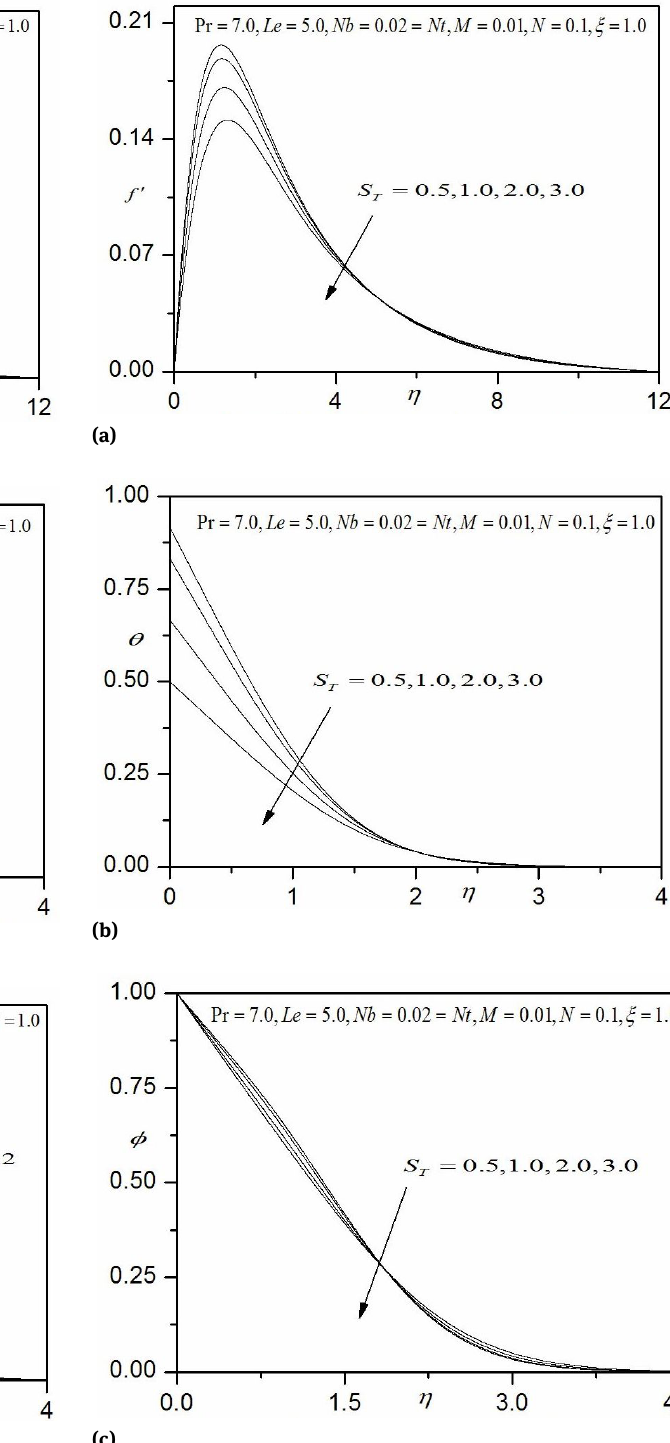
Fig. 8: Effect of Nt on (a) velocity profiles, (b) temperature profiles, Fig. 9: Effect of S T on (a) velocity profiles, (b) temperature